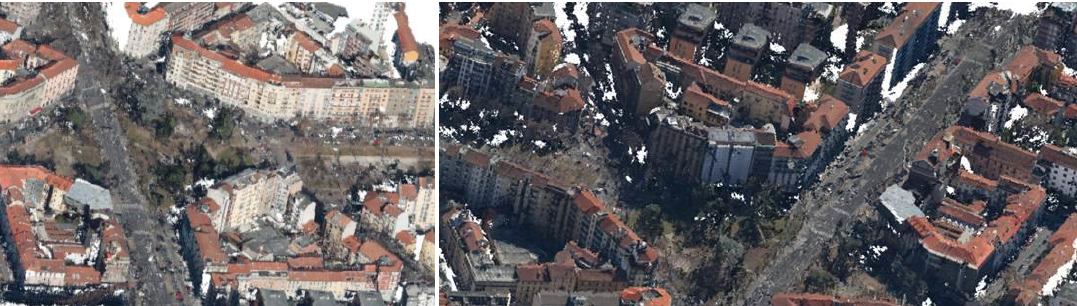
Figure 2. Example of a dense point cloud from oblique